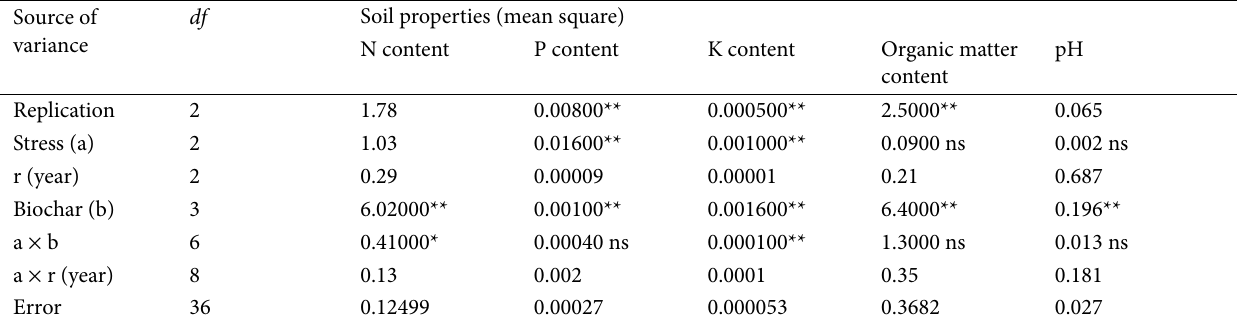
Table 8 Analysis of variance (ANOVA) for the effects of biochar on some soil properties under drought stress. Source of variance